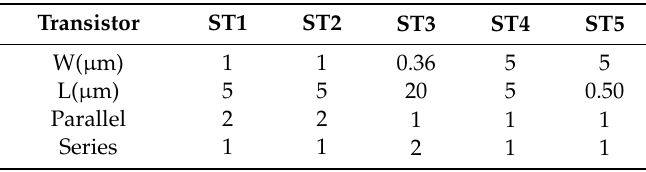
Table 6. Transistors dimensions of the start-up